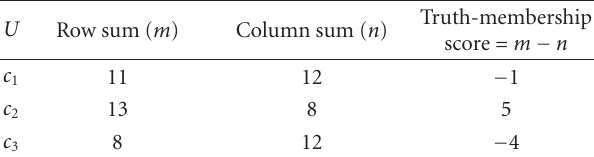
Table 9: Truth-membership score.